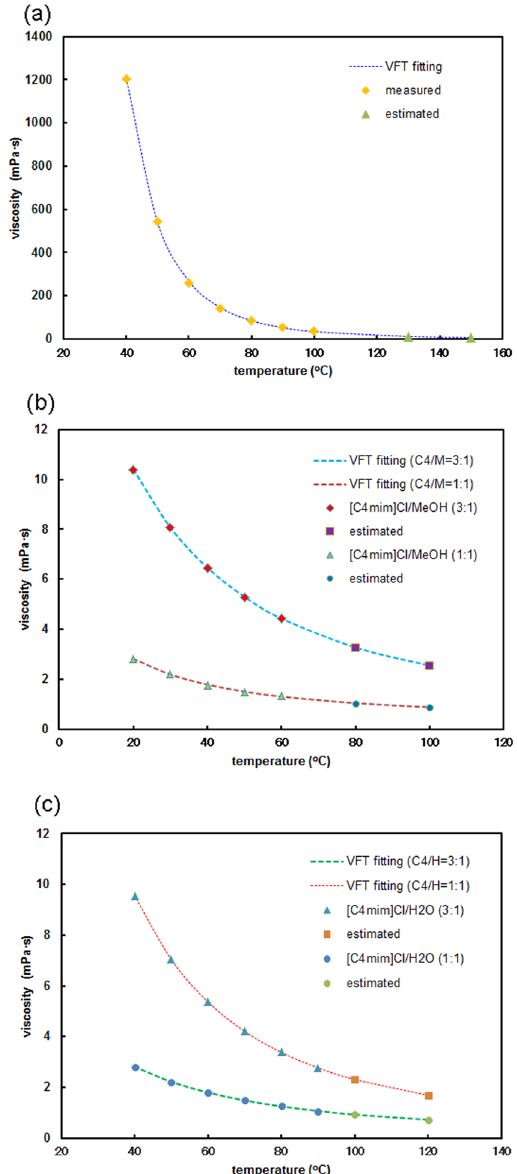
Figure 4. Viscosity of ( a ) [C 4 mim]Cl only (values at 130 and 150 °C estimated from VTF fitting 18 ), ( b ) [C 4 mim] Cl/MeOH (1:1 w/w, 3:1 w/w, and values at 80 and 100 °C estimated from VTF fitting 18 ), and ( c ) [C 4 mim]/H 2 O (1:1 w/w, 3:1 w/w, and values at 100 and 120 °C estimated from VTF fitting 18 ).